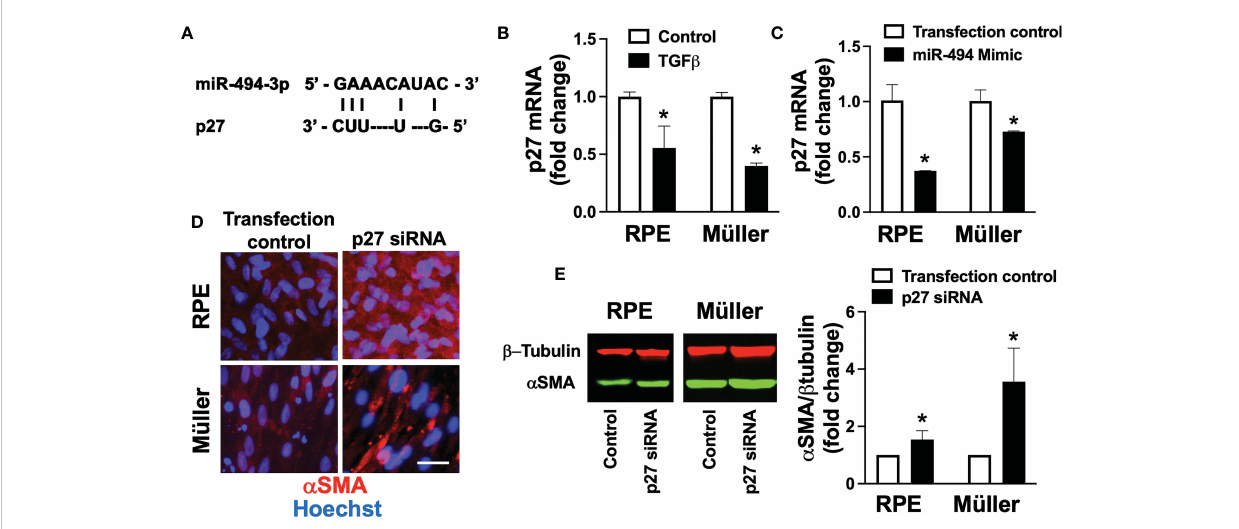
FIGURE 3 p27 in TGF b -induced fi brotic transformation. (A) Diagram of reverse complementary miR-494 and p27 binding sites. (B) Quanti fi cation of p27 mRNA in human RPE and Müller cell lines with and without TGF b treatment. (C) Quanti fi cation of p27 mRNA in human RPE and Müller cell lines with and without miR-494 mimic treatment. (D) Representative immuno fl uorescent images of a SMA (red) in human RPE and Müller cell lines with DAPI (blue) after 72h TGF b treatment with and without pre-treatment and co-incubation with p27 small interfering RNA (siRNA). (E) Quanti fi cation of a SMA in human RPE and Müller cell lines by immunoblot (representative blots left) after 72h TGF b treatment with and without pre-treatment and co- incubation with p27 siRNA. Mean ± SEM, * p<0.05 versus control